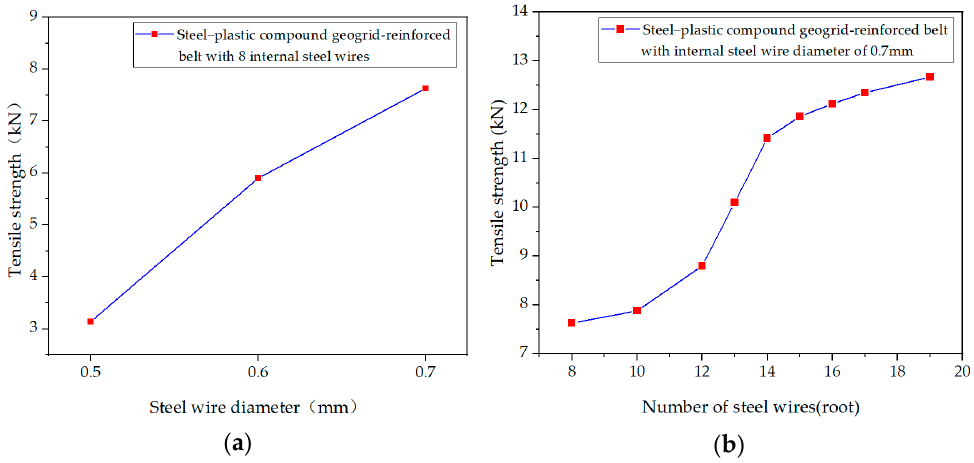
Figure 9. Influence of ( a ) steel wire diameter and ( b ) steel wire number on the tensile strength of the steel–plastic compound geogrid-reinforced belt.